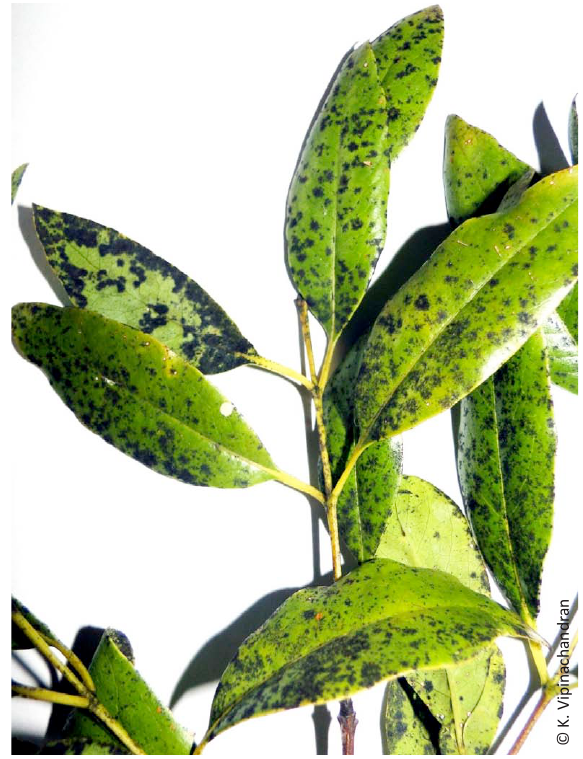
Image 1. Black mildew infected twigs of Santalum